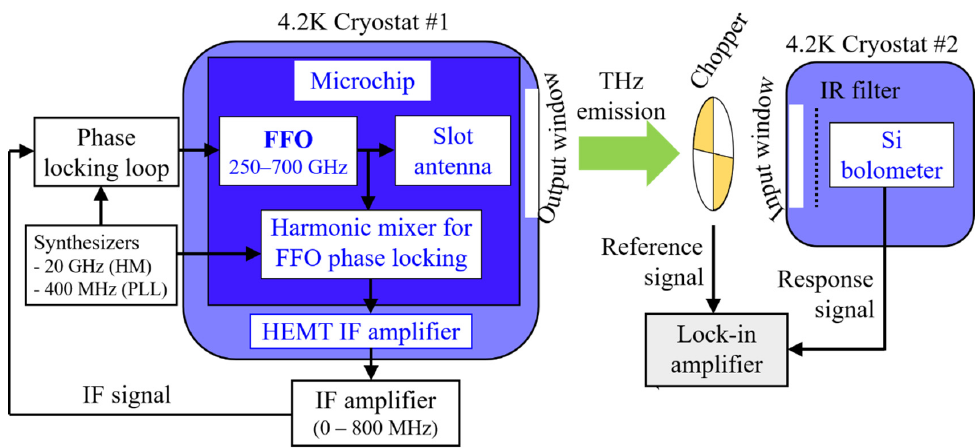
Figure 2. Block diagram of the setup for detecting the emission of the FFO-based source within a range of 250–700 GHz using a cooled Si bolometer. The chopper frequency is around 170 Hz.